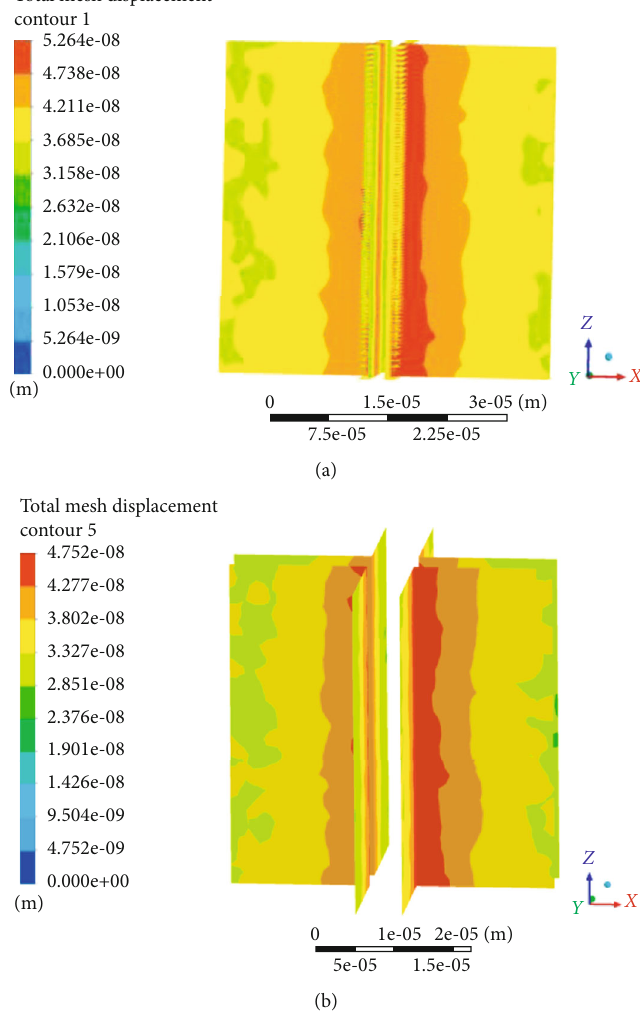
Figure 4: Total displacement of coal matrix with di ff erent fracture width: (a) 2 μ m and (b) 6 μ